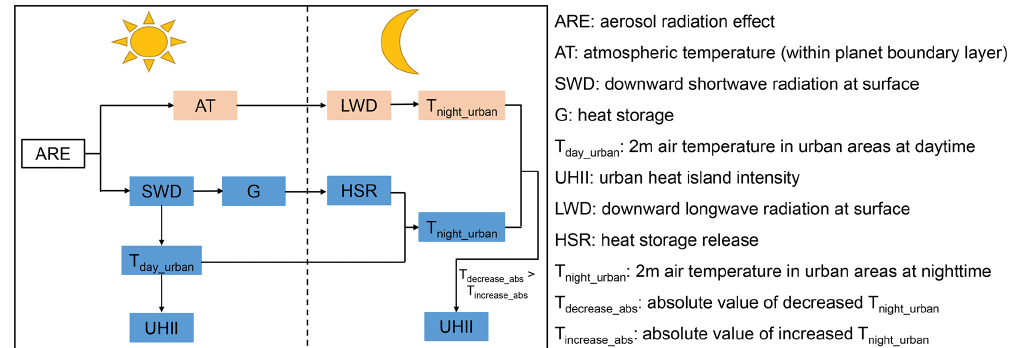
Figure 2. Flow chart showing how UHII is changed in daytime and nighttime, assuming that rural areas are not influenced by ARE. Pink boxes show a increasing trend while blue ones show a decreasing trend.